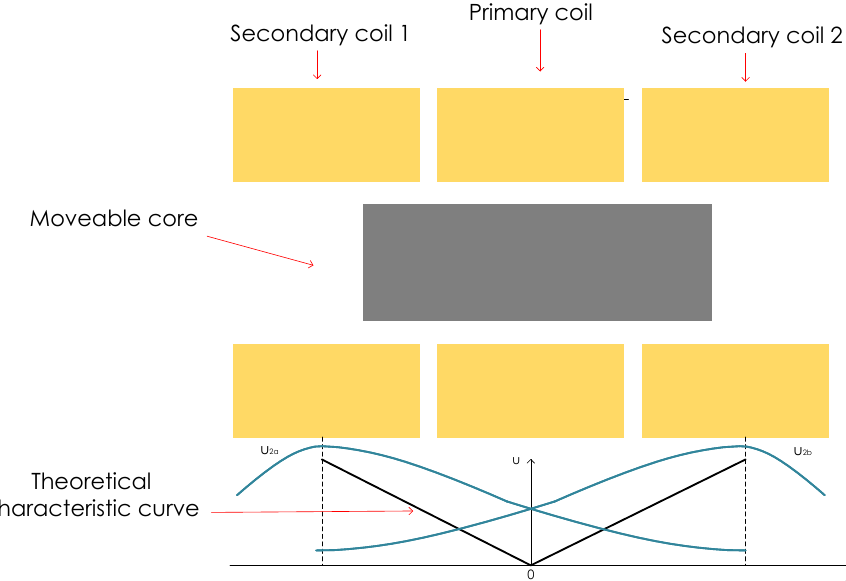
Figure 1. Structure of a LVDT with characteristic curve of output